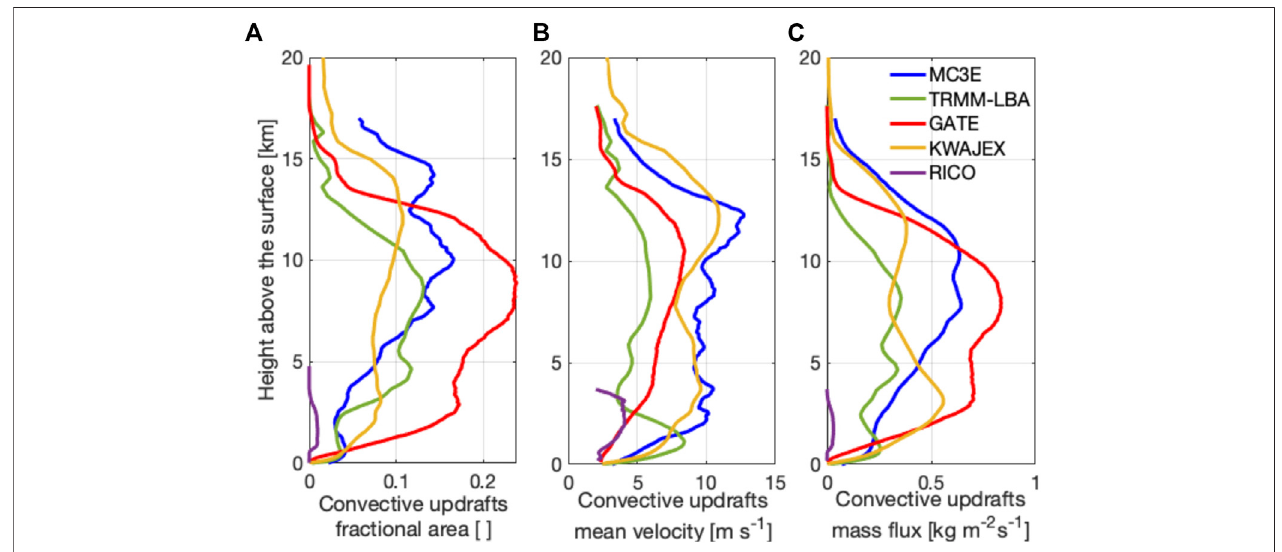
FIGURE 2 | Pro fi les of storm-averaged convective updraft (A) fractional area, (B) mean velocity, and (C) mass fl ux estimated directly from the numerical model simulations. Results are shown for the different cloud types under study (MC3E: blue, GATE: red, KWAJEX: yellow, TRMM-LBA: green, RICO: purple).